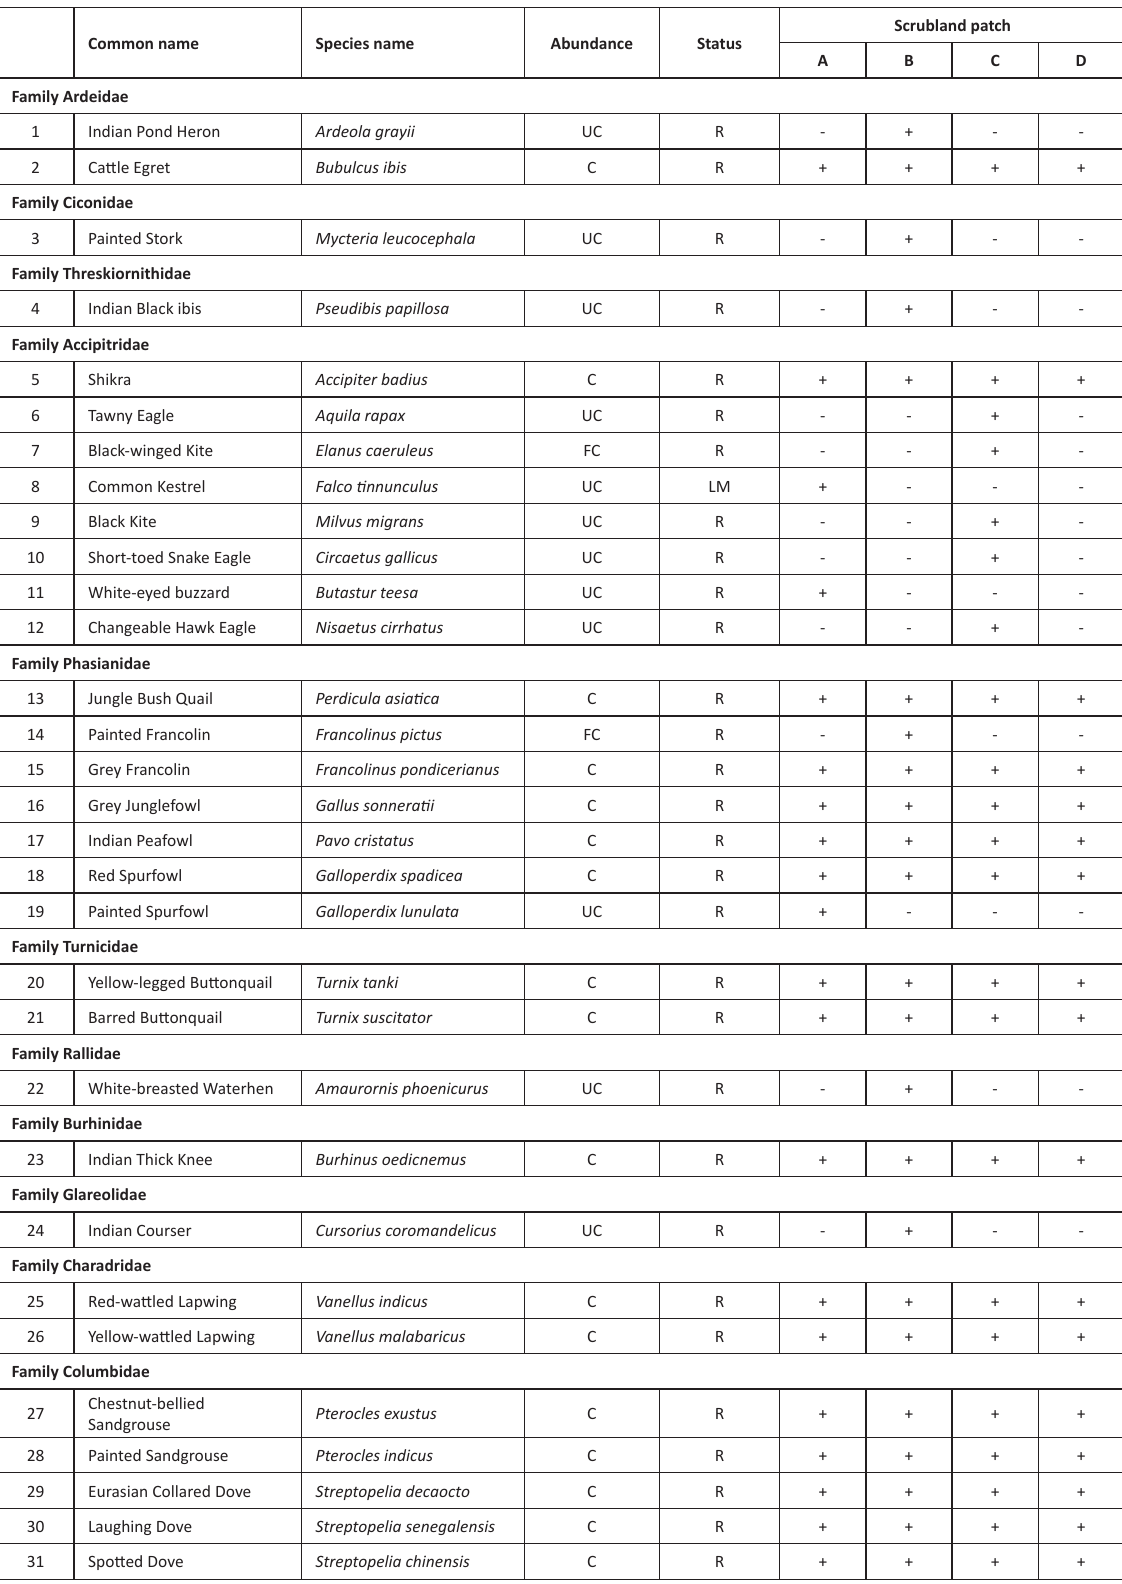
Table 1. List of birds in the scrub forest of Sri Lankamalleswara Wildlife Sanctuary, Andhra Pradesh,